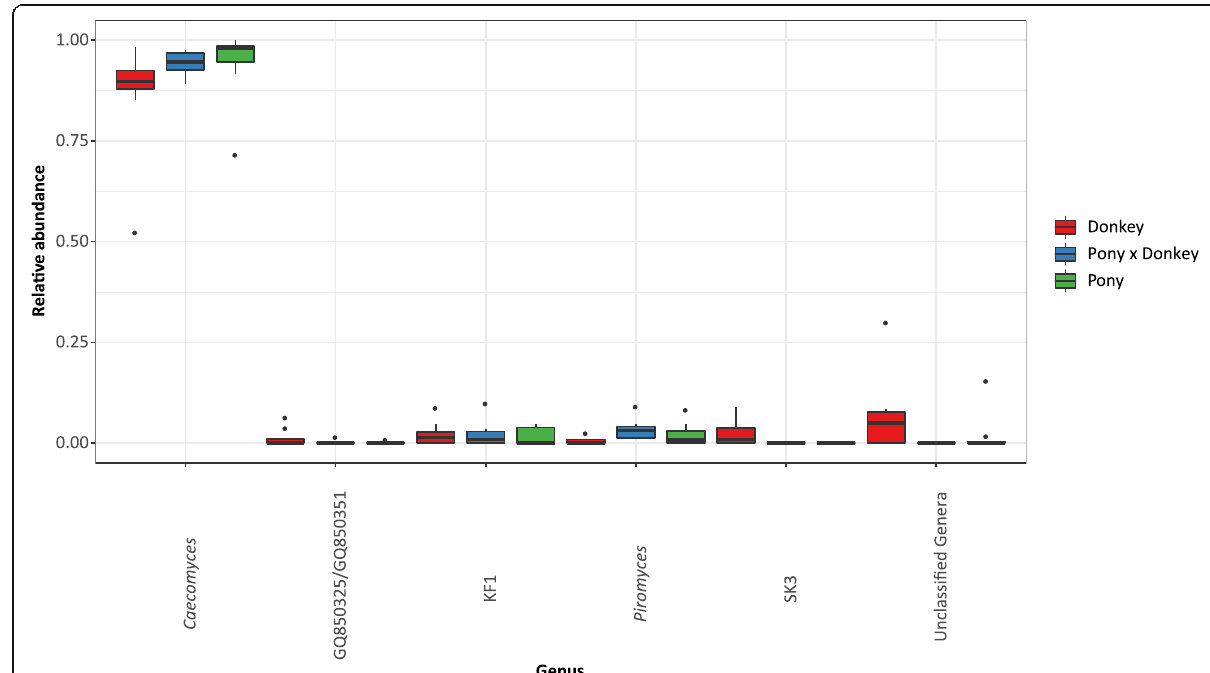
Fig. 3 Boxplot showing the anaerobic fungal genera detected in the different equine types. Genera that could not be classified are grouped as ‘ Unclassified Genera ’ . Boxes show the 25th and 75th percentiles with the median represented by a horizontal line. Whiskers show the data range with the exception of any outliers, which are indicated as data points